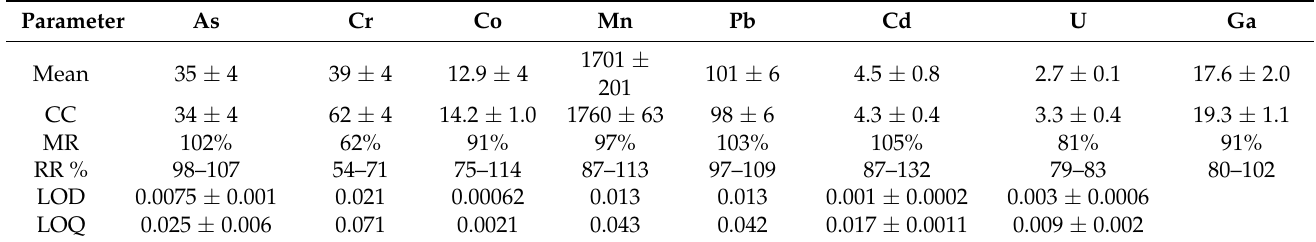
Table 1. Comparison between certified concentrations of As, Cr, Co, Mn, Pb, Cd, U, and Ga and respective mean measured concentrations in certified reference material NCS DC73319. Values are given in mg kg − 1 ( n =